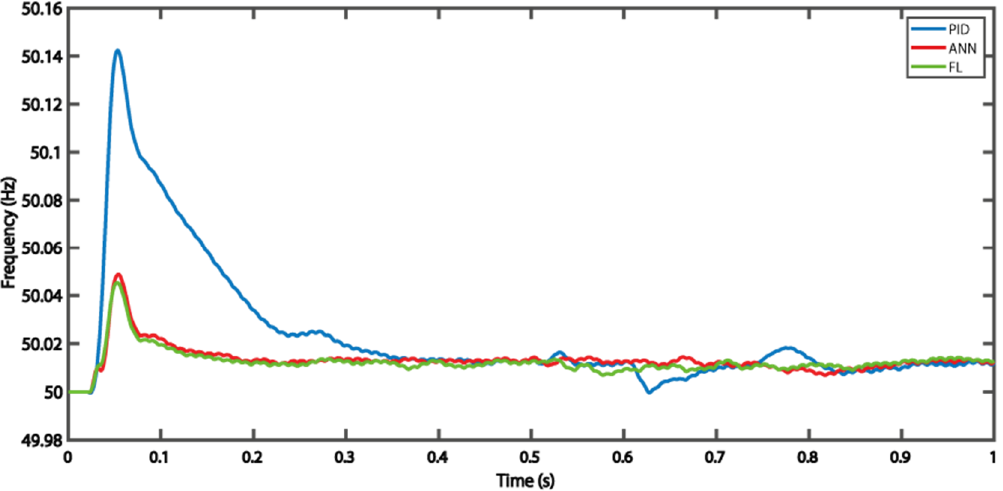
Figure 23. Measured frequency at the AC bus (Hz).